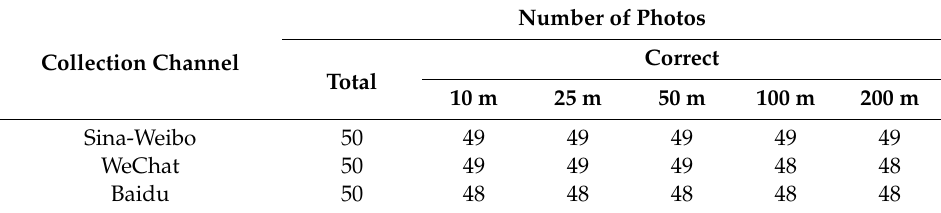
Figure 11. Five typical locations. Table 4. CA model accuracy for water level by comparing with a social-media-based dataset.